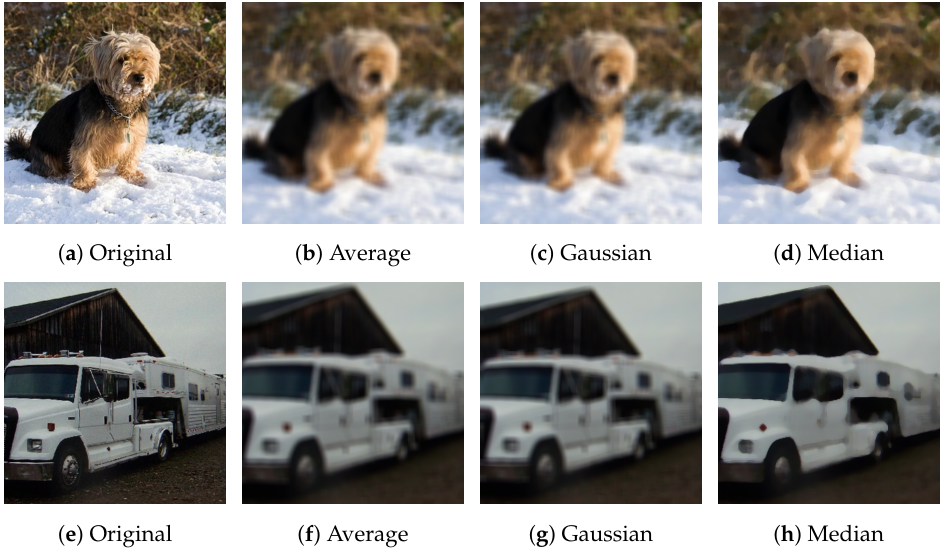
Figure 5. Image smoothing effect